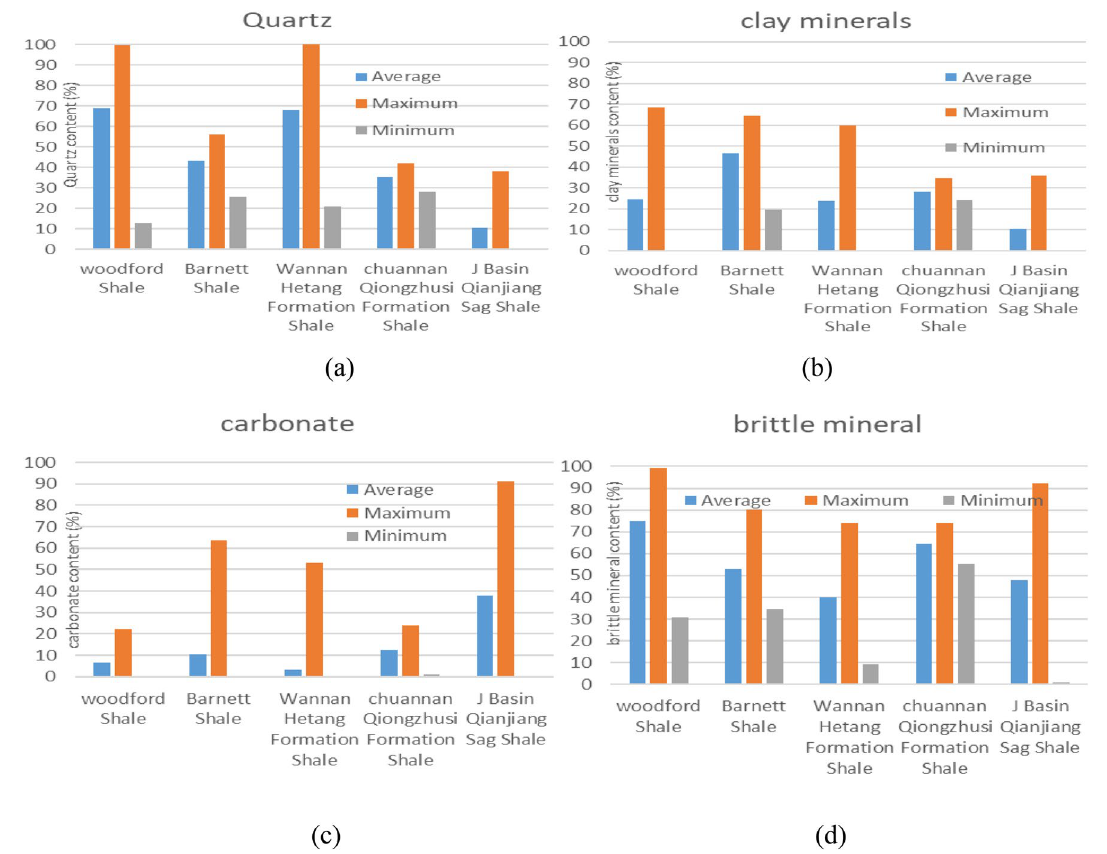
Fig. 2 Comparison of mineral composition of shale reservoirs in different blocks. Data sources : Jarvie et al. (2007), Zhao et al. (2014), Zhang et al. (2015)